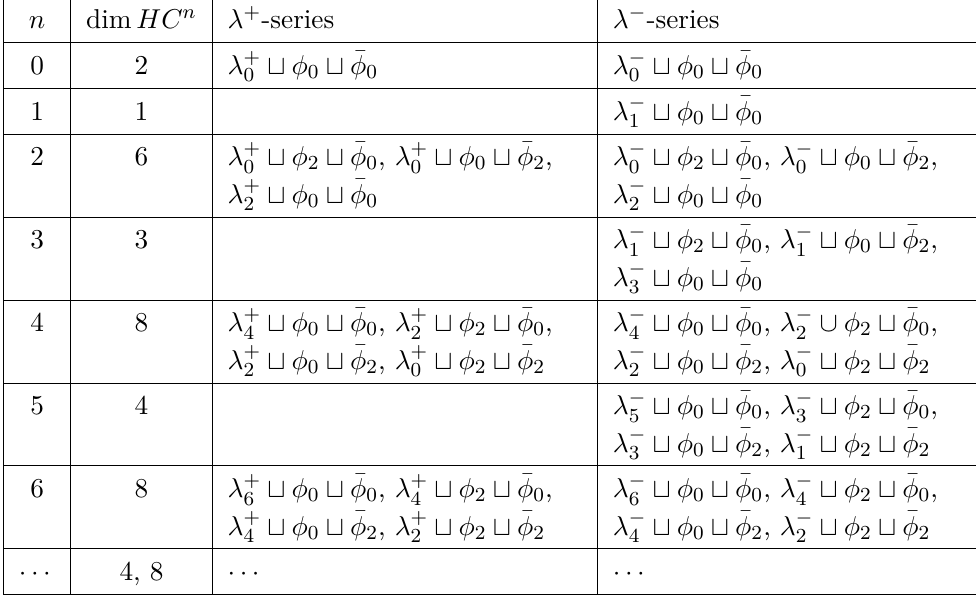
Table 6 . The cyclic cohomology classes of the algebra A ⊗ Λ . As is seen, the dimensions of the groups HC n ( A ⊗ Λ) stabilize starting from degree